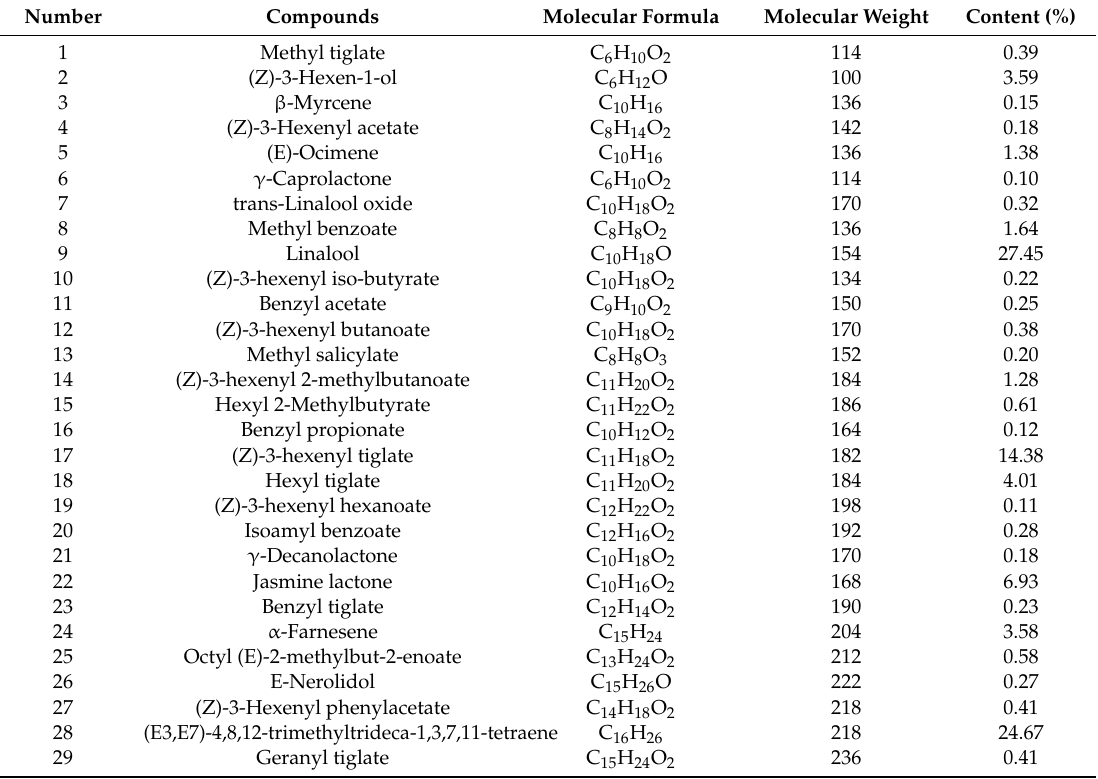
Table 1. Volatile components of G. jasminoides